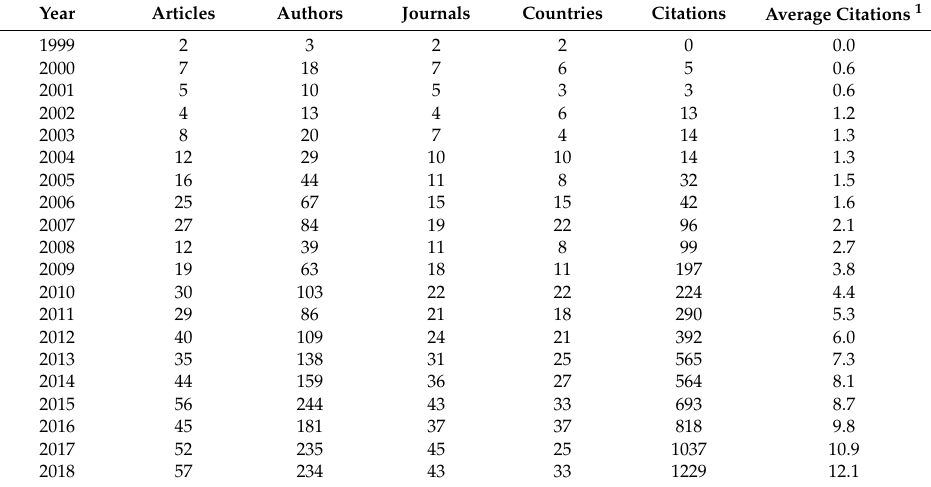
Table 1. Major characteristics of rainwater harvesting irrigation (RWHI)